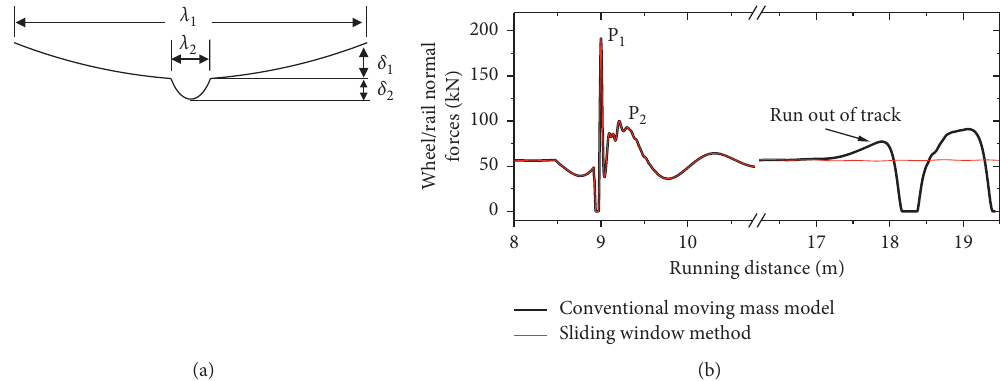
Figure 6: The vehicle passing over a rail joint irregularity: (a) rail joint irregularity model; (b) wheel/rail normal force variations owing to the rail joint irregularity excitation.